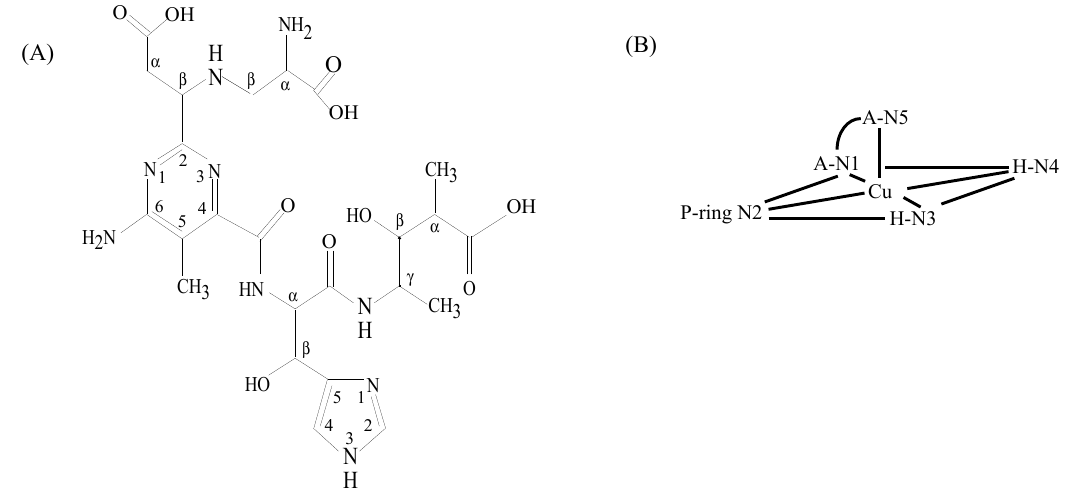
Figure 4. ( A ) Pseudotetrapeptide A and ( B ) Cu(II) coordination environment determined from the structure of Cu(II)-P3A